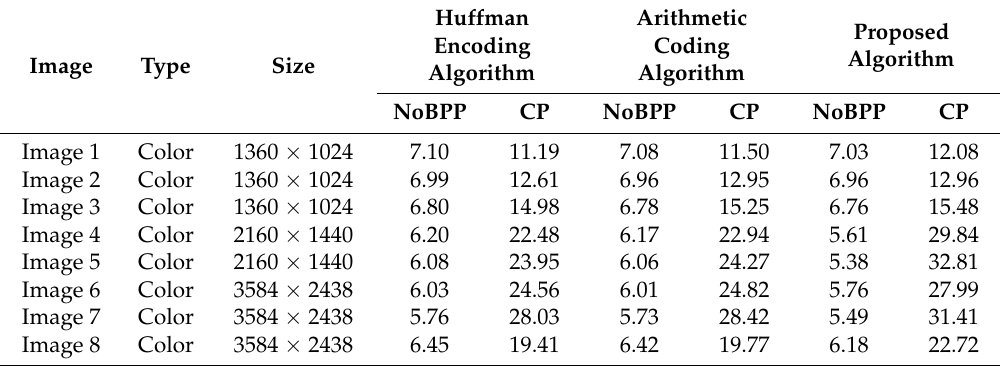
Table 9. Compression Percentages of Group 3 images.